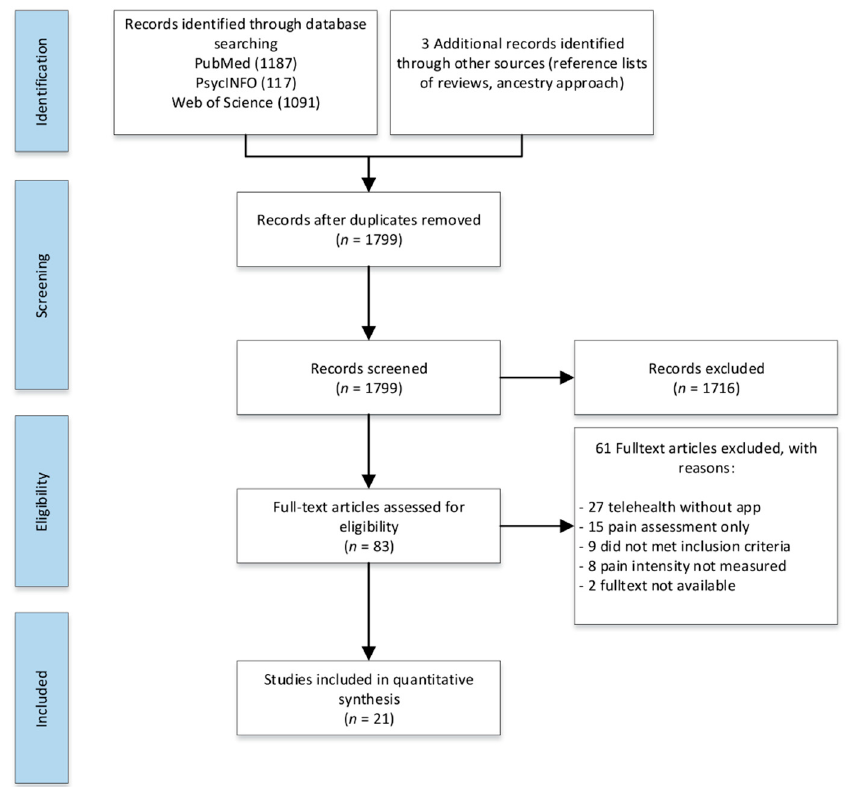
Figure 1. PRISMA flow